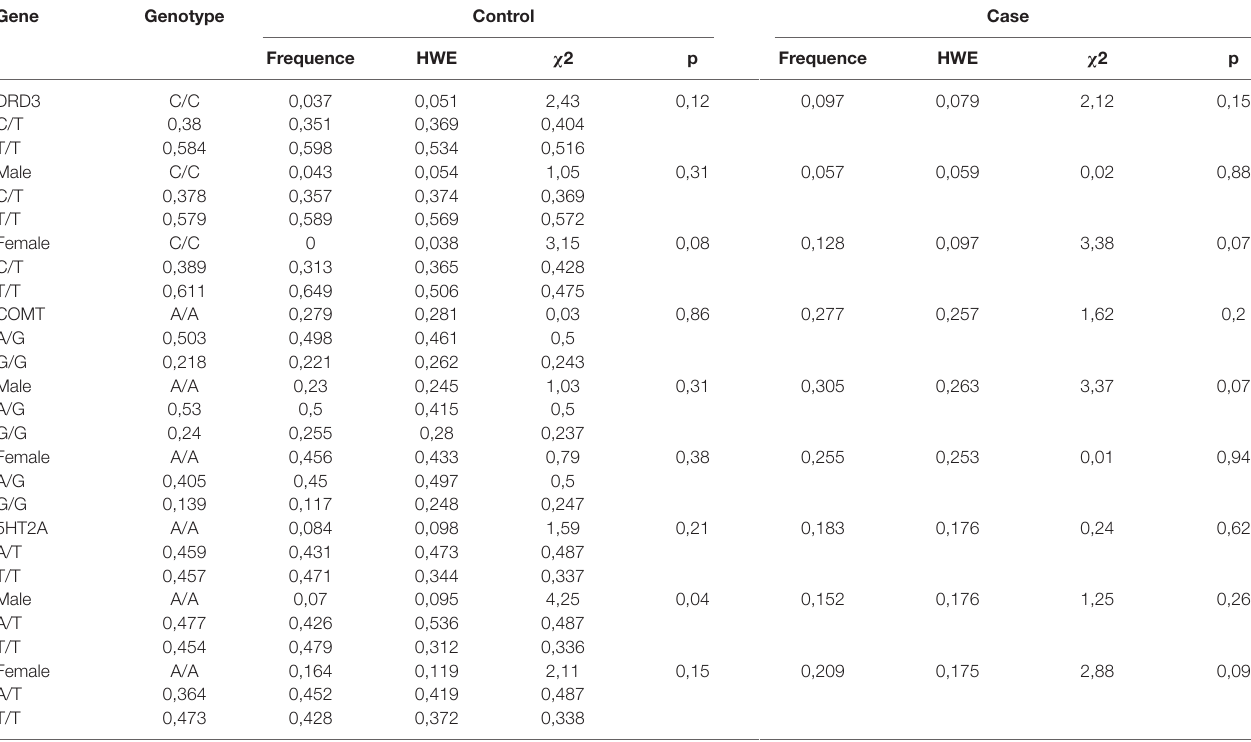
TABLe 1 | Genotype frequencies of rs6280 ( DRD3 ), rs4680 ( COMT ), and rs7322347 ( 5HT2A ) in the control and youth-onset schizophrenia groups. Gene Genotype Control Case Frequence Frequence